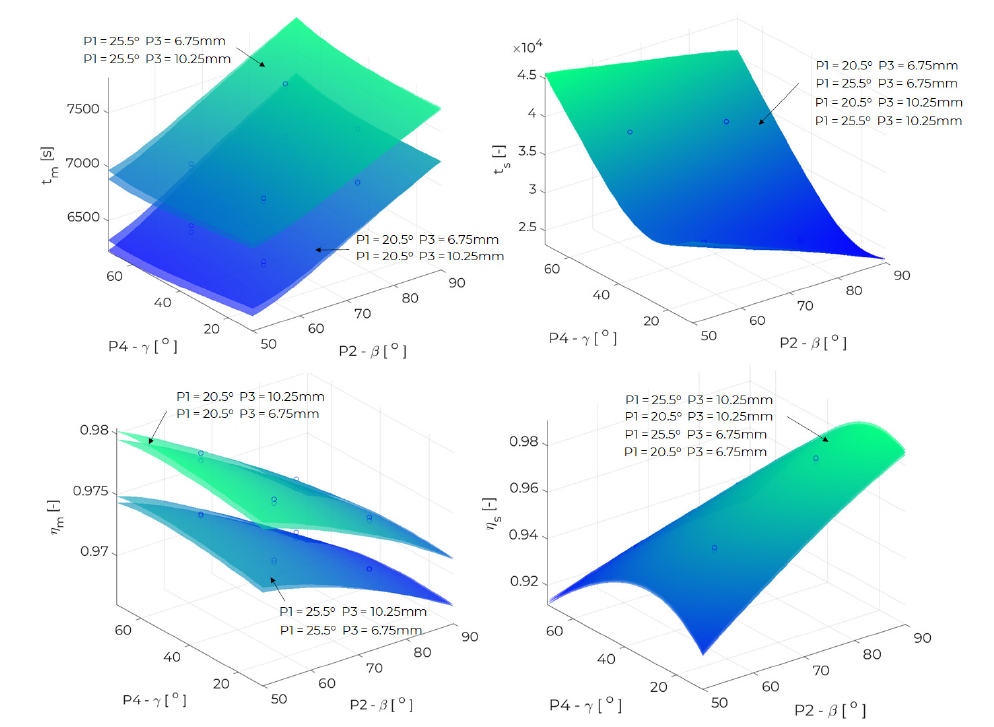
Figure 15. The response surface for inputs P2, P4, outputs t m , t s , η m , η s and (P1, P3) = [(20.5 ◦ , 6.75 mm), (20.5 ◦ , 10.25 mm), (25.5 ◦ , 6.75 mm), (25.5 ◦ , 10.25